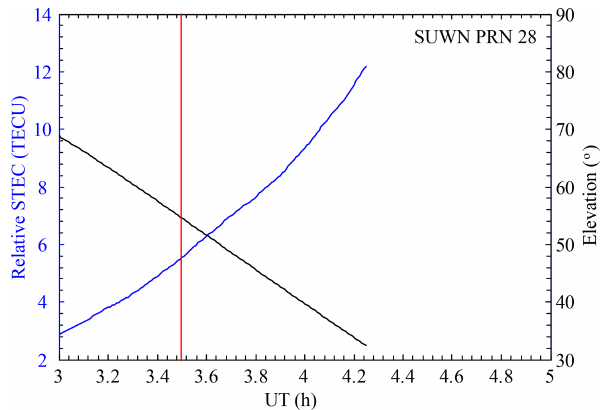
Figure 2. An example of the time series of relative STEC obtained by SUWN using satellite PRN 28 between 03:00 and 05:00UT on 3 September 2017. The explosion time is represented by the red